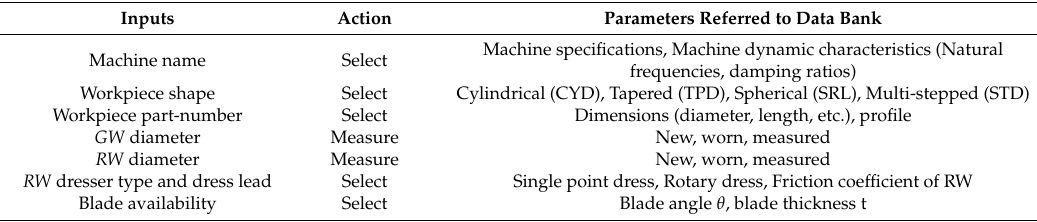
Table 1. Input information and parameters referred to data bank.